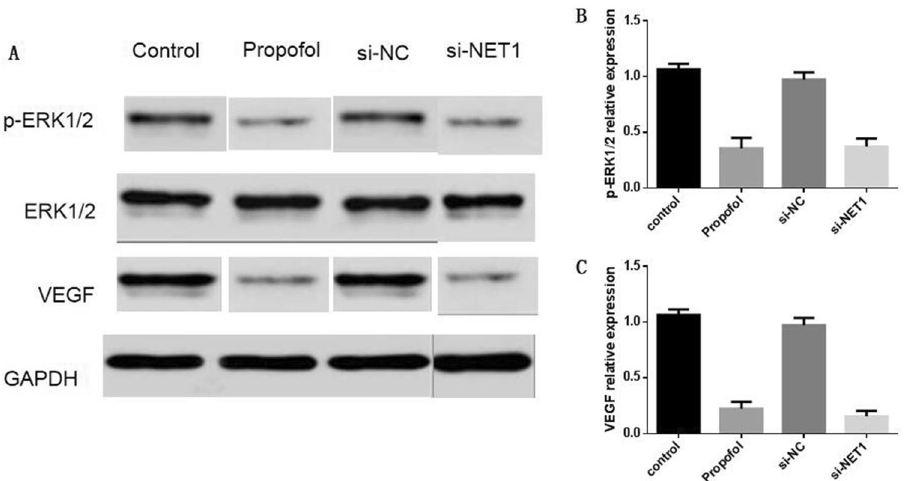
Figure 5. ( A ) The treatment of 100 μM Propofol for 48 h or NET1 silencing downregulated p‑ERK1/2 or VEGF protein level. ( B ) Statistical analysis on p‑ERK1/2protein level under various conditions. ( C ) Statistical analysis on VEGF protein level under various